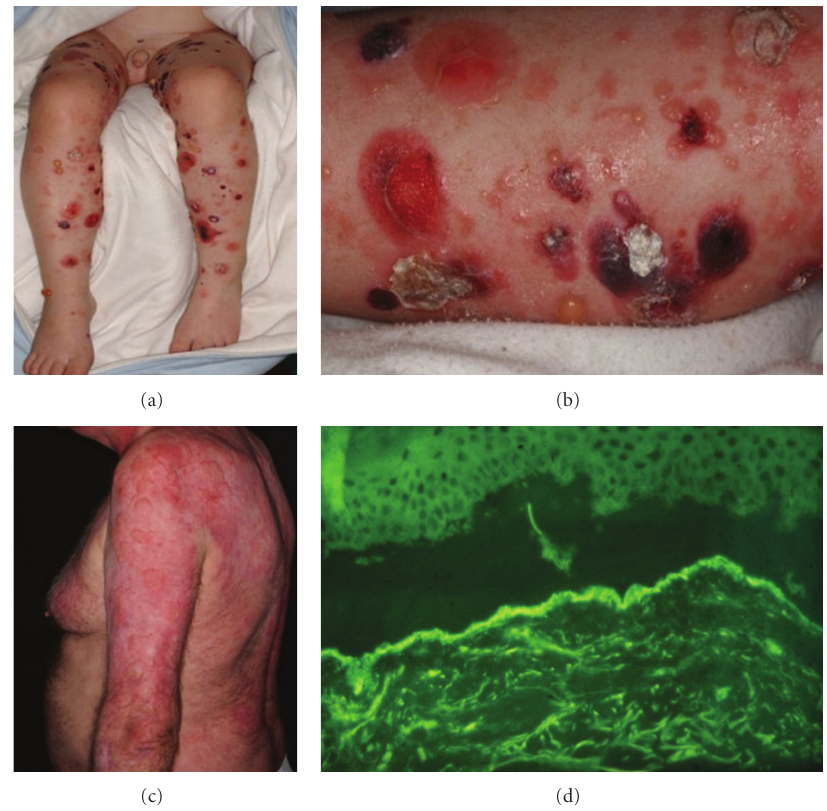
Figure 4: Juvenile bullous pemphigoid and bullous eruption of systemic lupus erythematosus. ((a) and (b)) Tense blisters and hemorrhagic crusts on the extremities of a 5-year- old boy with juvenile BP. (c) Erythematous plaques and some blisters in a VBSLE patient. (d) Circulating IgG antibodies bind to the dermal site of SSS in